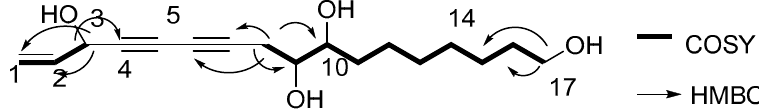
Figure 2. Correlation spectroscopy (COSY) correlations and heteronuclear multiple bond correlation (HMBC) correlations of new compound 1.